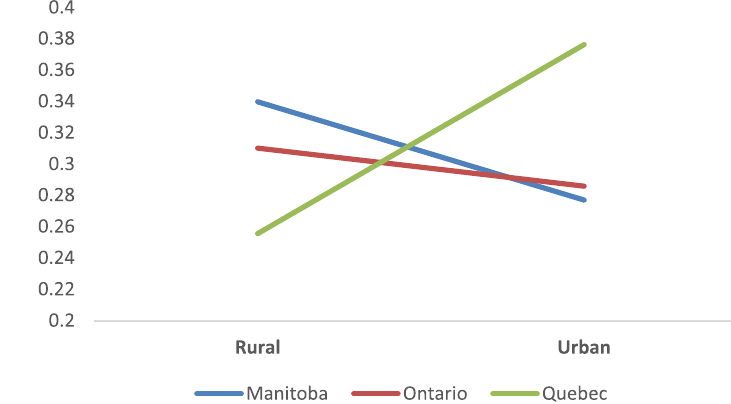
Fig. 1 Probability of using recreational cannabis, past month